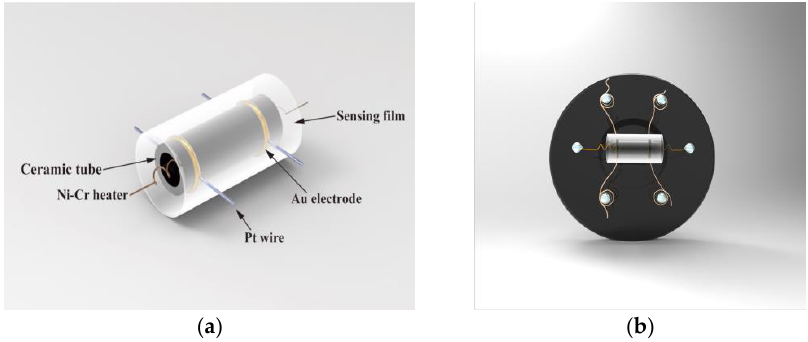
Figure 1. Schematic diagram of ( a ) ceramic tube and ( b ) the indirect-heating sensor.